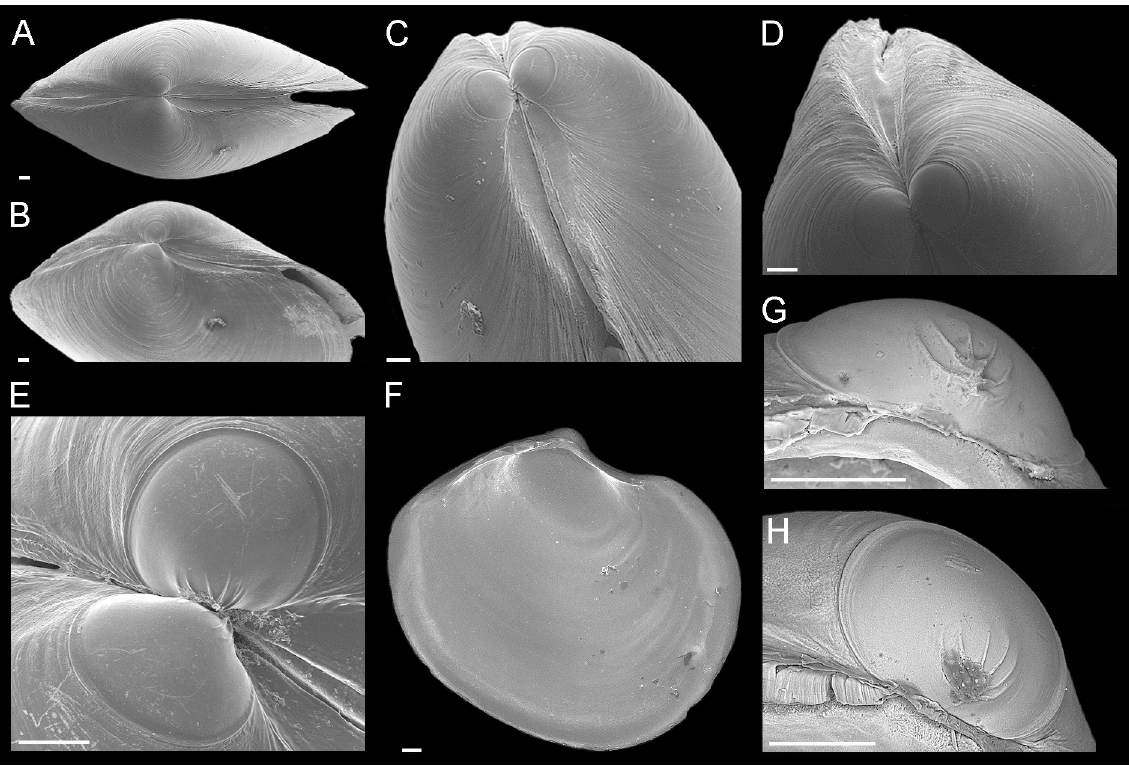
Fig. 10. Scanning electron micrographs of Parathyasira pauli sp. nov. (IORAS OBF collection Cat. BIV00041). A–B . Dorsal and oblique dorsal views of both valves. C . Lunule. D . Escutcheon. E . Prodissoconchs. F . Interior view of left valve of young specimen, shell length 1.3 mm. G–H . Prodissoconchs of different specimens. Scale bars = 100